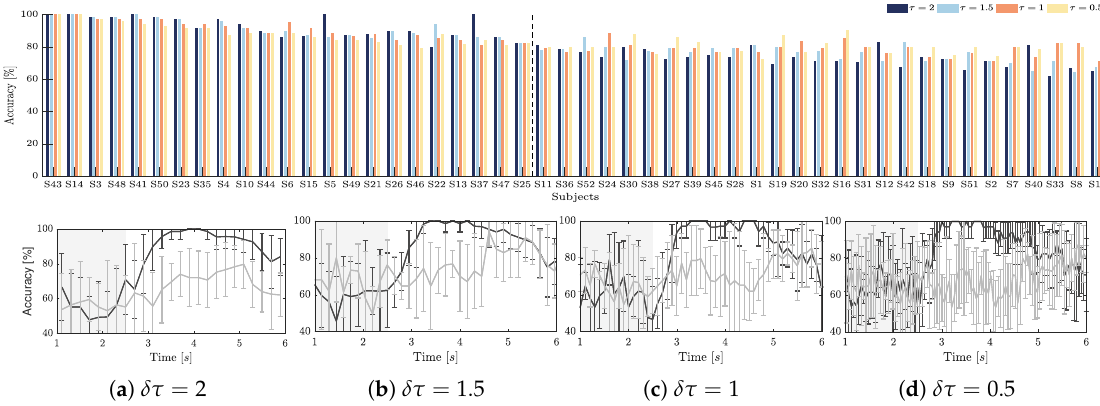
Figure 3. Individual accuracy in distinguishing either MI class performed by the CSP-based time-frequency feature set, using different window lengths: – δτ = 2, – δτ = 1.5, – δτ = 1, – δτ = 0.5. Bottom row: Accuracy for the trial timing using different windows S14 (marked with color – ) and S17( –